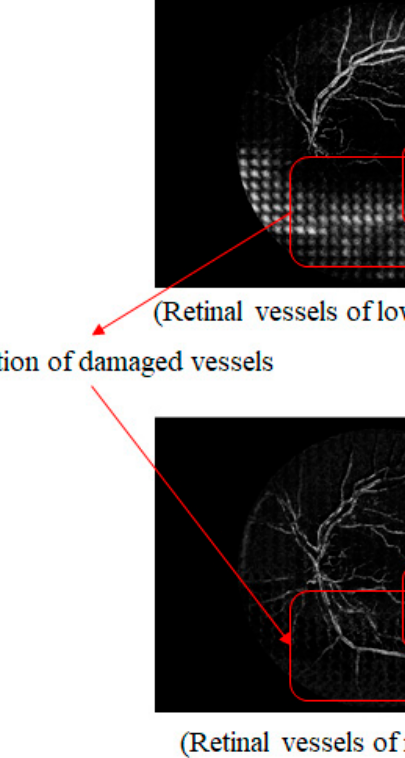
Figure 14. Comparison of low-quality retinal and synthetic vessel images.